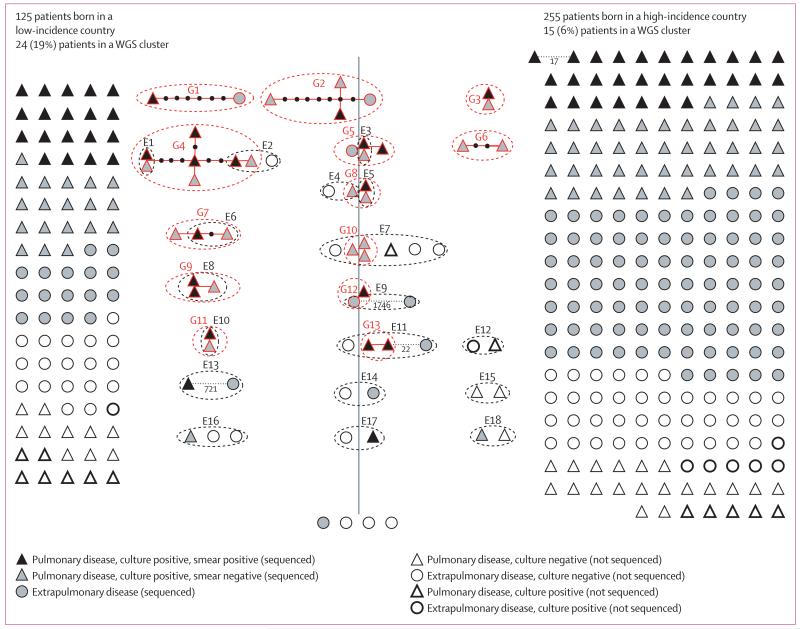
All cases in Oxfordshire, UK, (2007–12) by incidence in country of birth, and by epidemiological and genomic clusteringPatients born in low-incidence countries are on the left and those born in high-incidence countries are on the right of the figure. Four patients whose country of birth was not known are at the bottom centre of the figure. Each shape (triangle or circle) represents a patient. Epidemiological clusters (E1–18) are circled in black and genetic links, shown as networks with edges representing the genetic distance, are circled in red. Edges in networks are red for distances within 12 SNPs. Genetic links of interest but greater than 12 SNPs are indicated by black dashed lines, representing the SNP distances. Patients in WGS clusters who are zero SNPs apart are indicated by shapes that abut each other, whereas distances of at least 1 SNP are quantified by the number of red lines (separated by small black nodes if >1 SNP) between patients. Epidemiological or WGS clusters that include patients born in low-incidence countries and patients born in high-incidence countries cross the central vertical line. SNP=single-nucleotide polymorphism. WGS=whole-genome sequencing.